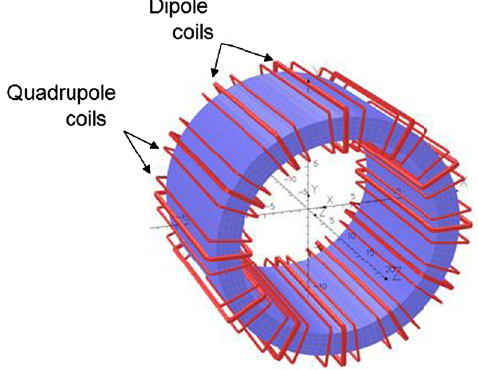
FIG. 4. Combiner with combined dipole and quadrupole fields. The ferrite core is 20 cm long with an inner radius of 10 cm.